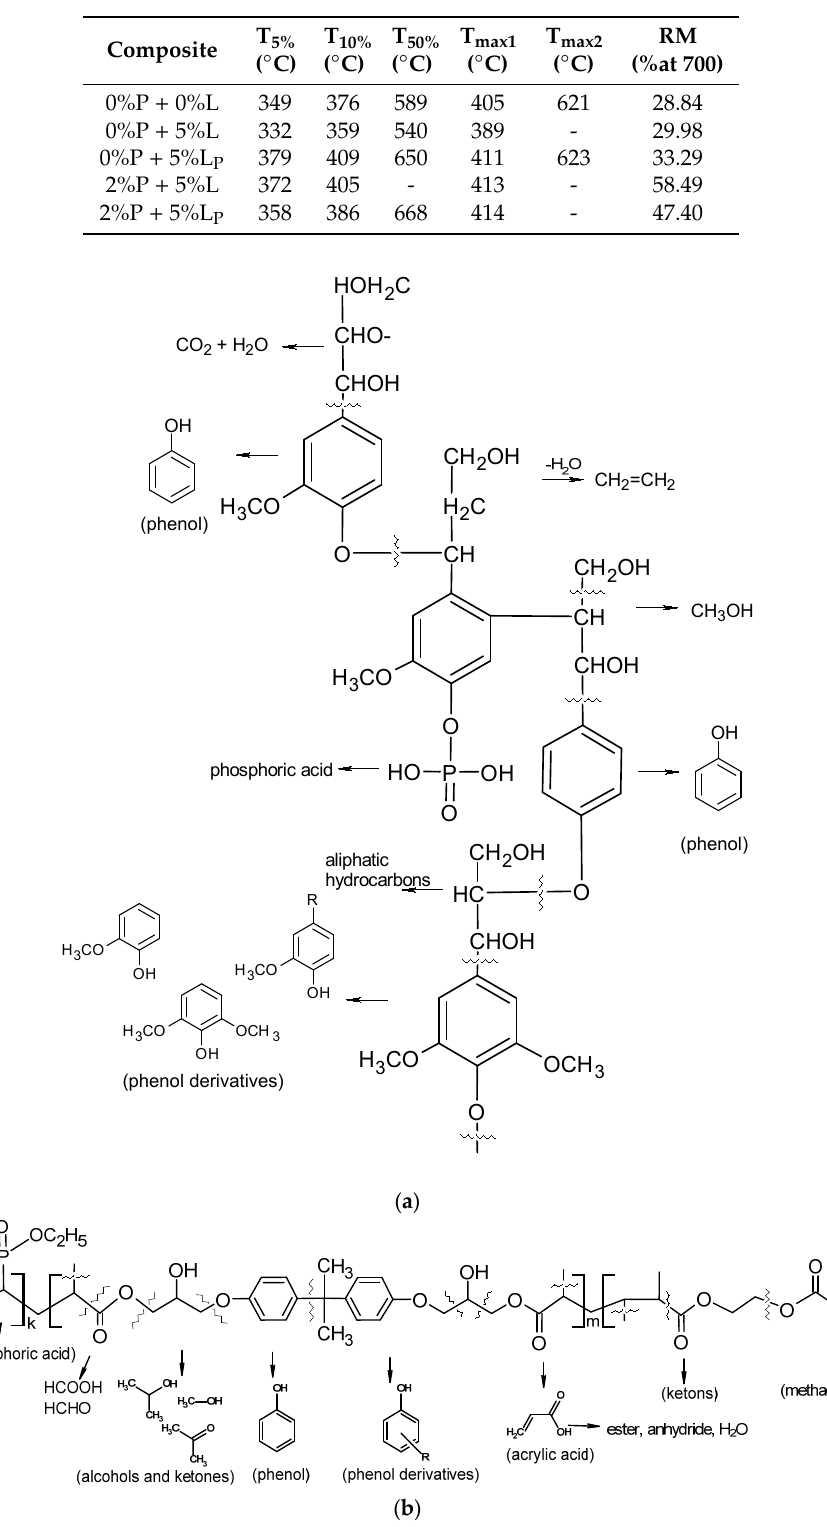
Figure15. Proposedmechanismsofmodifiedlignin( a )andcopolymers( b Figure 15. Proposed mechanisms of modified lignin ( a ) and copolymers ( b ) fragmentation under heating.